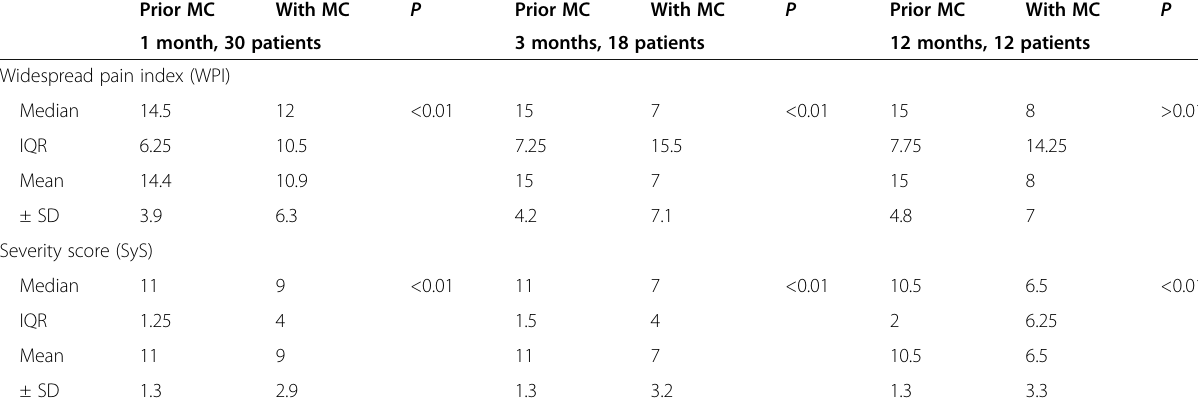
Table 10 Effects of medical cannabis on fibromyalgia syndrome at 1, 3, and 12 months Prior MC With MC P Prior MC With MC P Prior MC With MC 1 month, 30 patients 3 months, 18 patients 12 months, 12